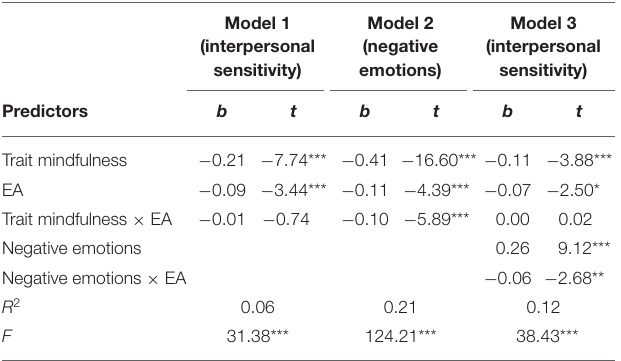
TABLE 3 | Testing the moderated mediation effect of trait mindfulness on interpersonal sensitivity.